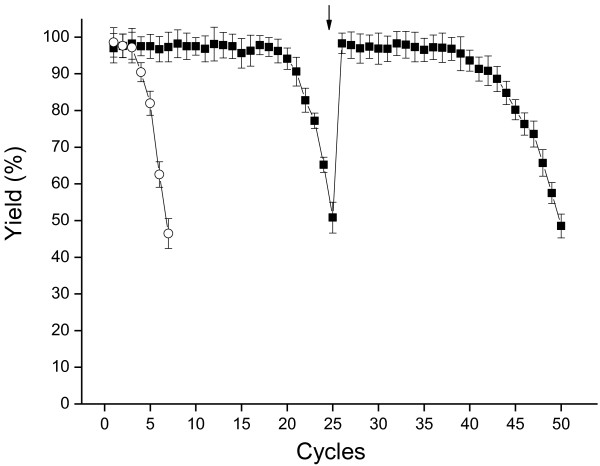
The repeated asymmetric reduction of 4′-chloroacetophenone with the complex-immobilized cells and free cells. Repeated actions were carried out with the free cells (○) and the complex immobilized cells (▪) in 8 mL TEA-HCl buffer (100 mmol/L, pH 5.0) containing 130 mmol/L of isopropanol and 5.0 mmol/L of 4′-chloroacetophenone, 4.7 g ww immobilized biocatalyst or 0.48 g wet free cells, 30°C, 160 rpm, reaction time for each batch was 60 min. Arrow: recultivation of 24 h was carried out as described in Materials and methods.